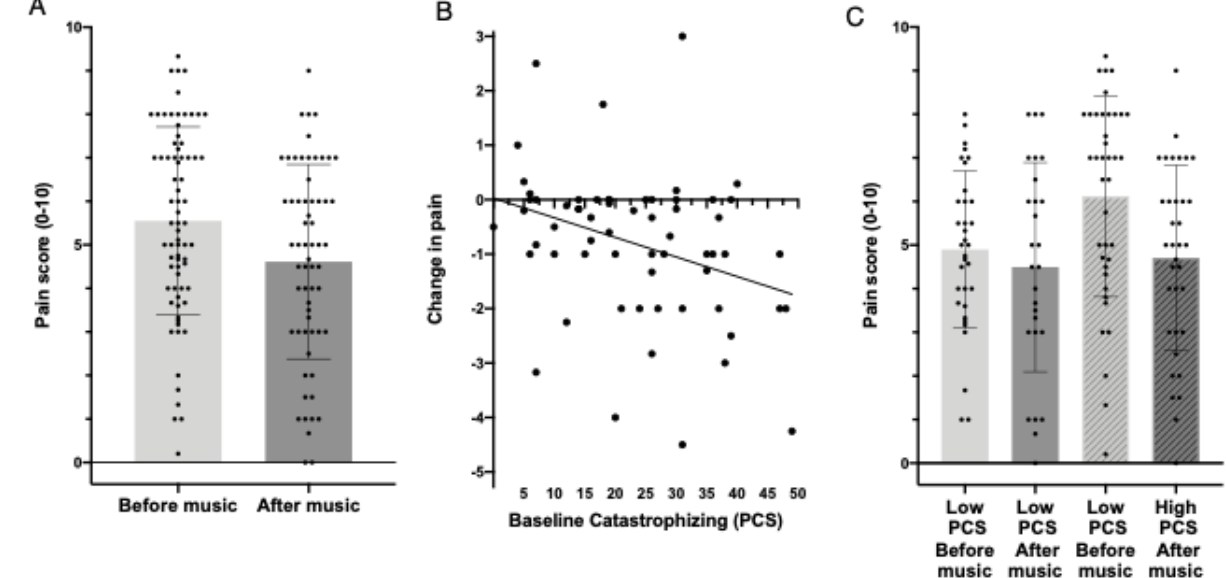
Figure 2. Effect of music on pain in emergency department patients. (A) Comparison of mean pain scores before and after music interventions revealed a significant overall reduction in pain scores in most individuals (related-samples Wilcoxon signed rank test, P <.001). The mean change in pain score with music was modest (mean difference –0.81, 95% CI –0.45 to –1.16) with considerable variability among participants. (B) Baseline Pain Catastrophizing Scale (PCS) score measured before music interventions was correlated with the amount of change in pain after music session. Higher baseline PCS scores were associated with a larger decrease in pain after music session (Spearman ρ =–0.39, P =.009). (C) Change in pain after music among low and high catastrophizers. Patients with high baseline PCS score (>20) had a greater decrease in pain (mean difference –1.2, SD 1.4) after music session than those with lower PCS (mean difference –0.3, SD 1.1; independent-samples t test=–2.9, P